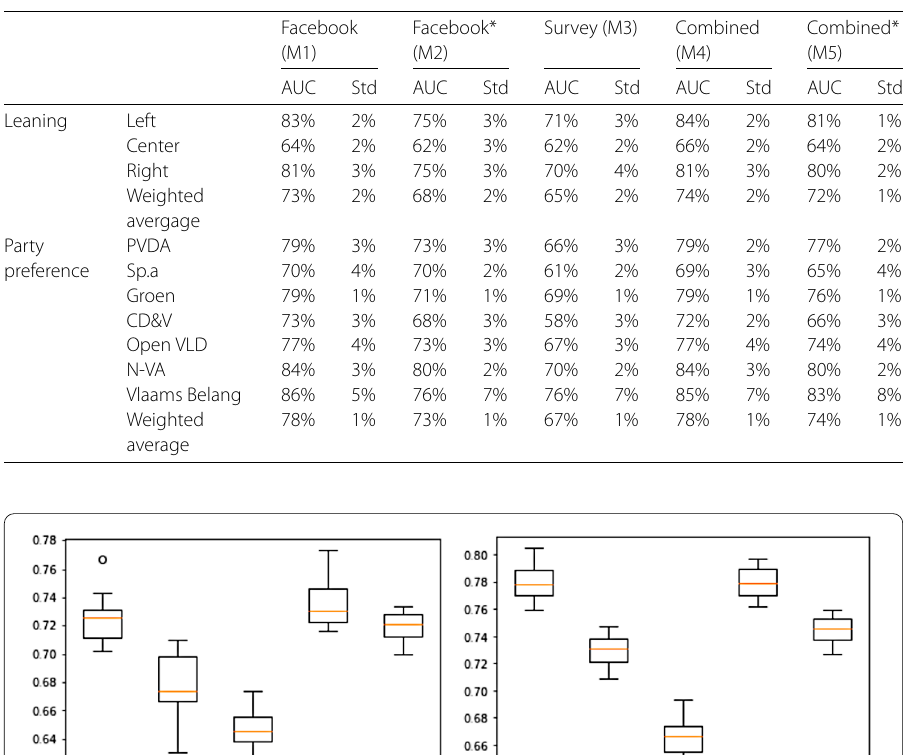
Table 3 AUC and the standard deviation (std) for models build on (non-political) Facebook pages, survey data or a combination thereof.